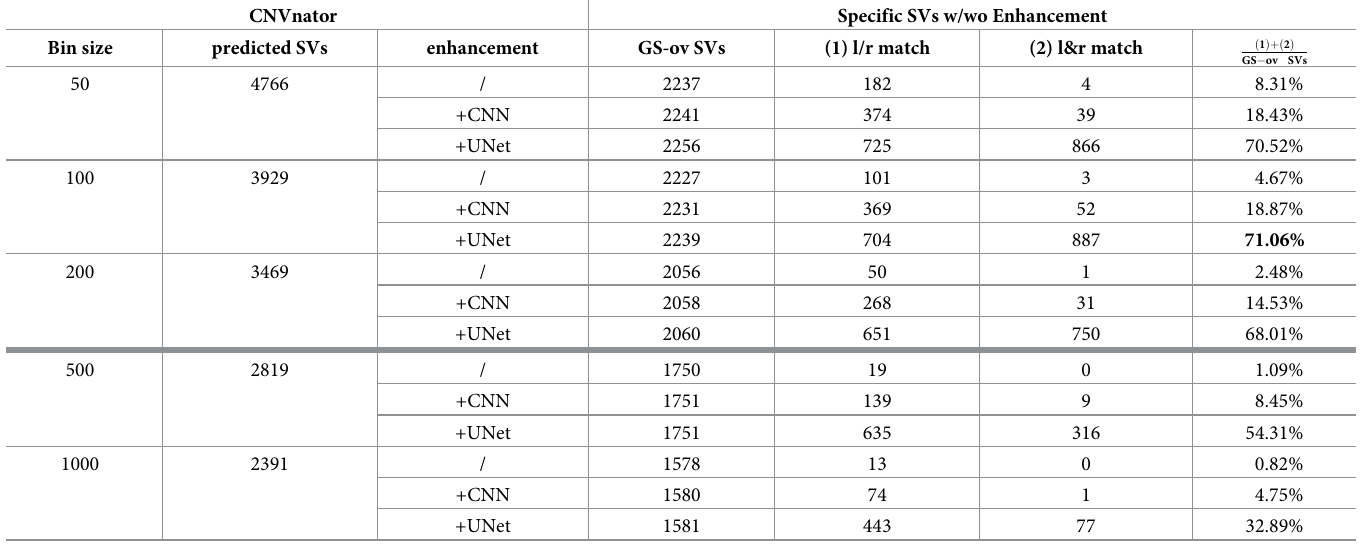
Table 2. Enhancement of the predicted SVs by CNVnator using different bin sizes. The length of the screening window surrounding predicted breakpoints is 400 bp. “GS-ov” SVs are referred to as gold-standard overlapping SVs. “l/r match” represents SVs with partial-boundary-match (left or right), and “l&r match” denotes SVs with both-boundary-match (left and